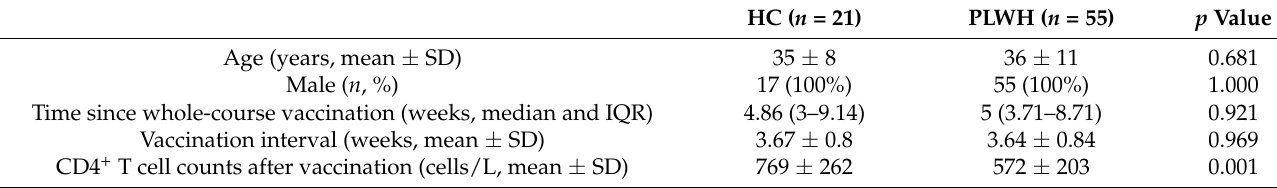
Table 5. Characteristics of PLWH and HC who had vaccinated with two doses of CoronaVac vaccine for at least 2